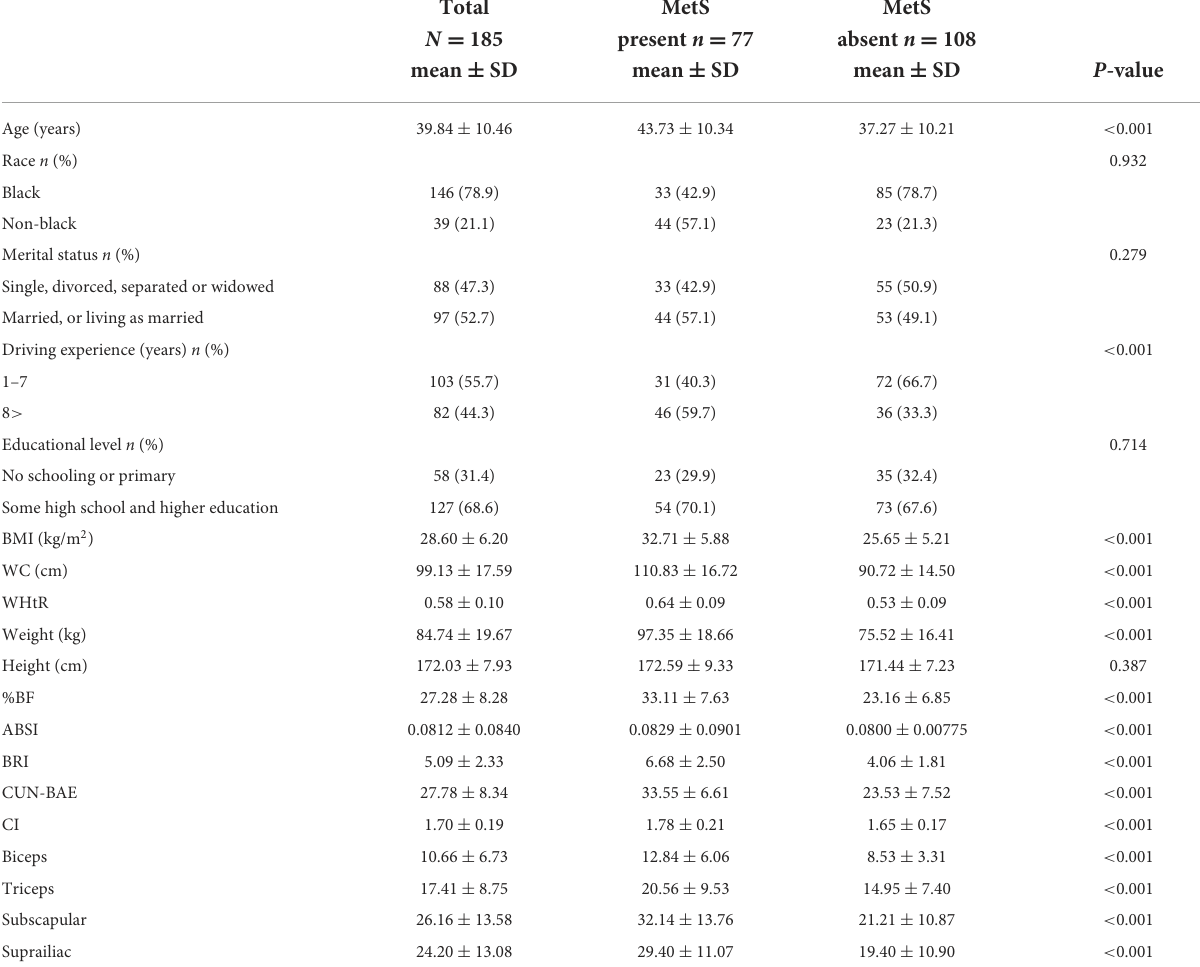
TABLE 1 Sociodemographic and anthropometric characteristics by the presence/absence of MetS among the taxi drivers in Western Cape, South